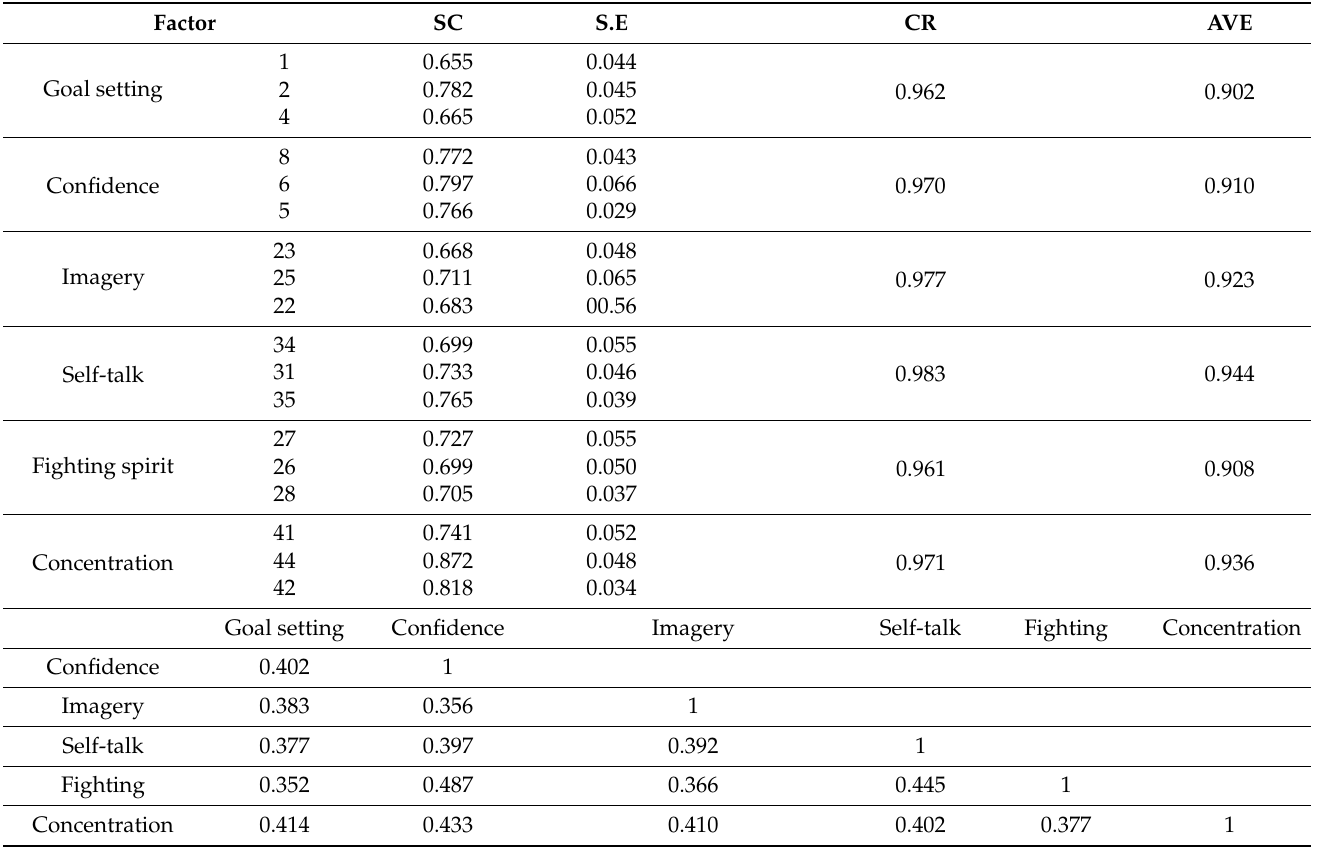
Table 14. Results of ML